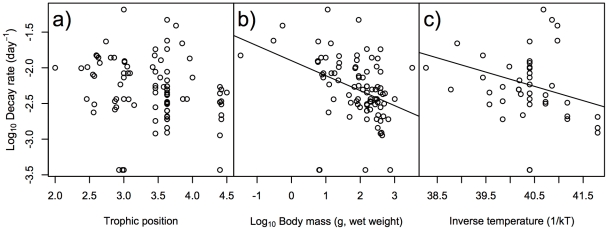
Effects of ecological/biological traits of species on decay rate of 137Cs activity concentration in fish.Effects of a) trophic position of species, b) body mass (g, wet weight) of species, and c) inverse temperature (1/kT) of the environment on log10 decay rate (day−1) on 137Cs activity concentration in fish. Lines indicate a significant relationship by the best GLMM, with the coefficient and intercept estimated by GLMM.